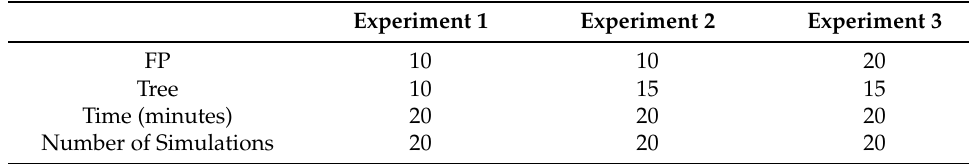
Table 1. Scenario of experiment.